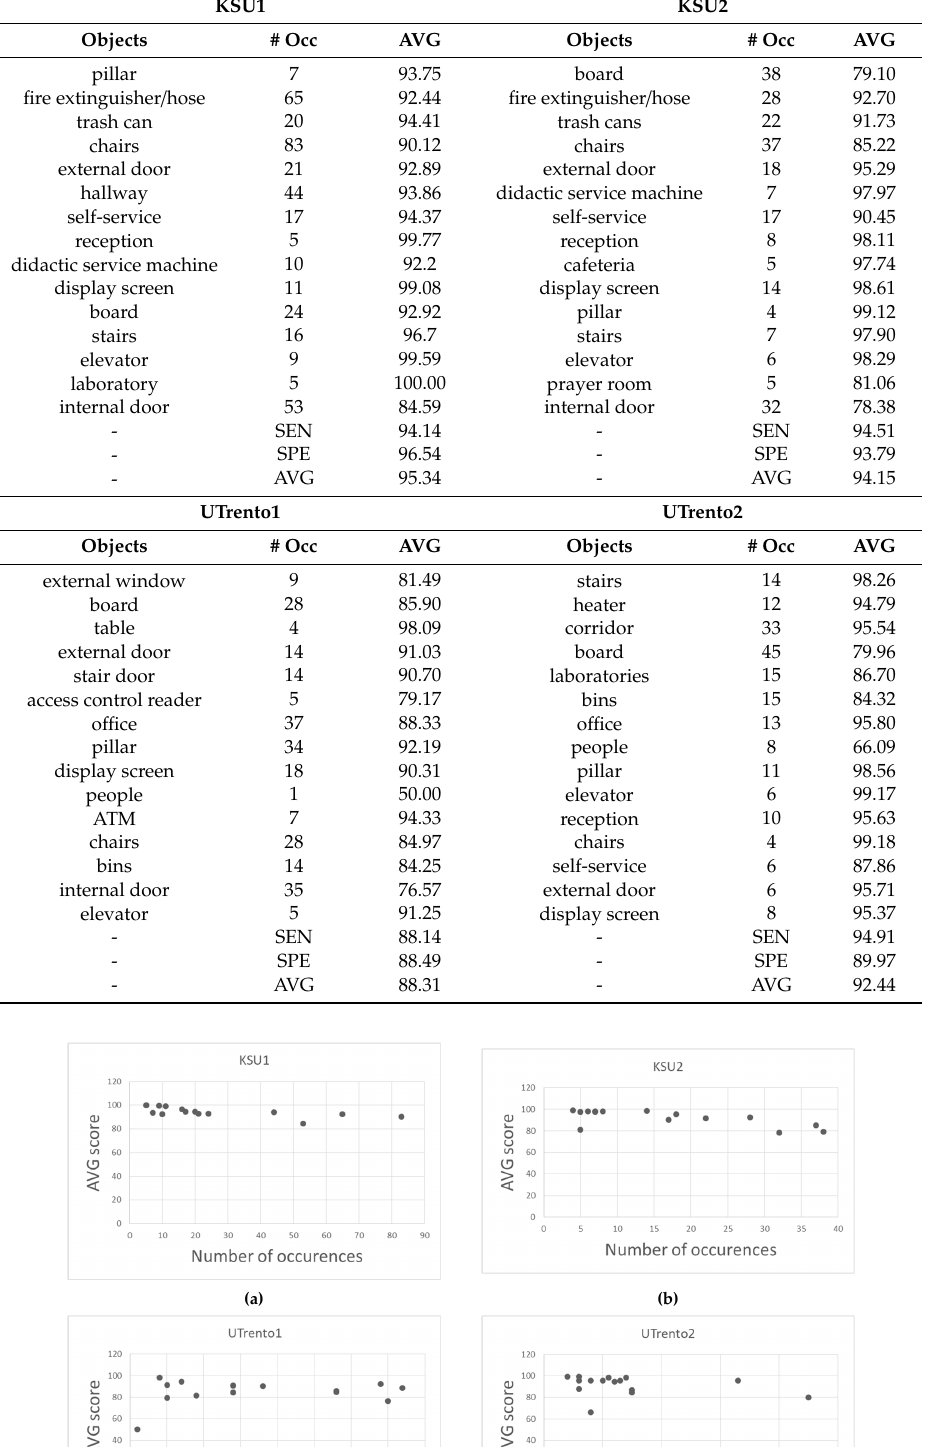
Table 3. Detailed results per object using Model 3 with the CONV2D layer size = 256 and T p = 0.3.